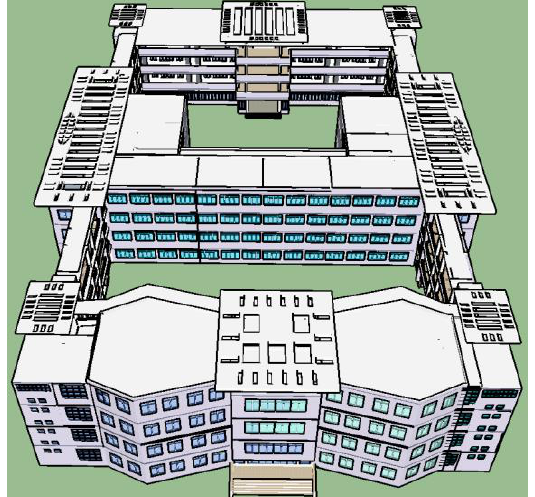
Figure 3. The overview of the Henan University of